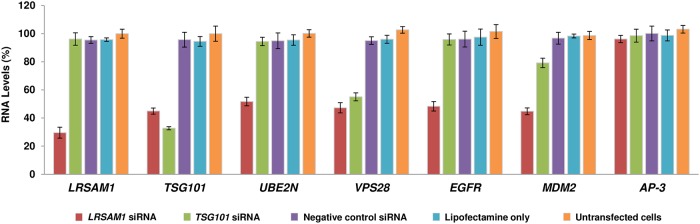
Investigation of LRSAM1 interacting molecules in LRSAM1 or TSG101 downregulated cells.Quantification of the RNA expression levels of the interacting molecules relative to the Untransfected control cells, which was set to 100 96h after the first siRNA transfection. Values were obtained as ratios of the RNA of interest over GAPDH control. Specifically, LRSAM1 downregulation significantly decreased the levels of LRSAM1 (30% ±3.86%, p<0.0275), TSG101 (45% ±2.19%, p<0.0092), UBE2N (52%±3.05%, p<0.0158), VPS28 (47%±3.62%, p<0.0336), EGFR (49%±3.38%, p<0.0125) and MDM2 (45%±2.44%, p<0.0096) compared to the Untransfected control cells. In contrast, AP-3 (96%±2.59%, p<0.0109) showed similar expression between the LRSAM1 knocked down and Untransfected cells. TSG101 downregulation significantly decreased the levels of TSG101 (33% ±1.11%, p<0.0068) and VPS28 (55%±2.86%, p<0.0154) and also caused a small decrease of MDM2 (79%±3.37%, p<0.0217) compared to the Untransfected cells. Expression levels of LRSAM1 (96% ±4.41%, p<0.0427), UBE2N (94%±2.97%, p<0.0172), EGFR (96%±3.96%, p<0.0298) and AP-3 (99%±4.57%, p<0.0462) were similar to the Untransfected cells.